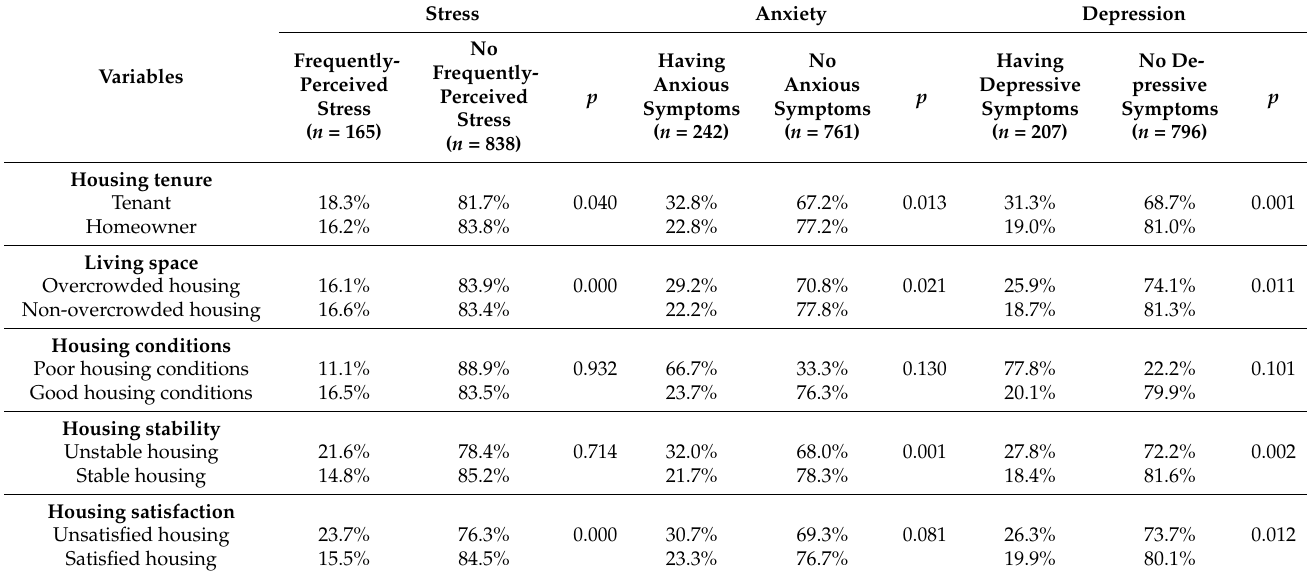
Table 2. Differences in individual mental health outcomes by housing status.